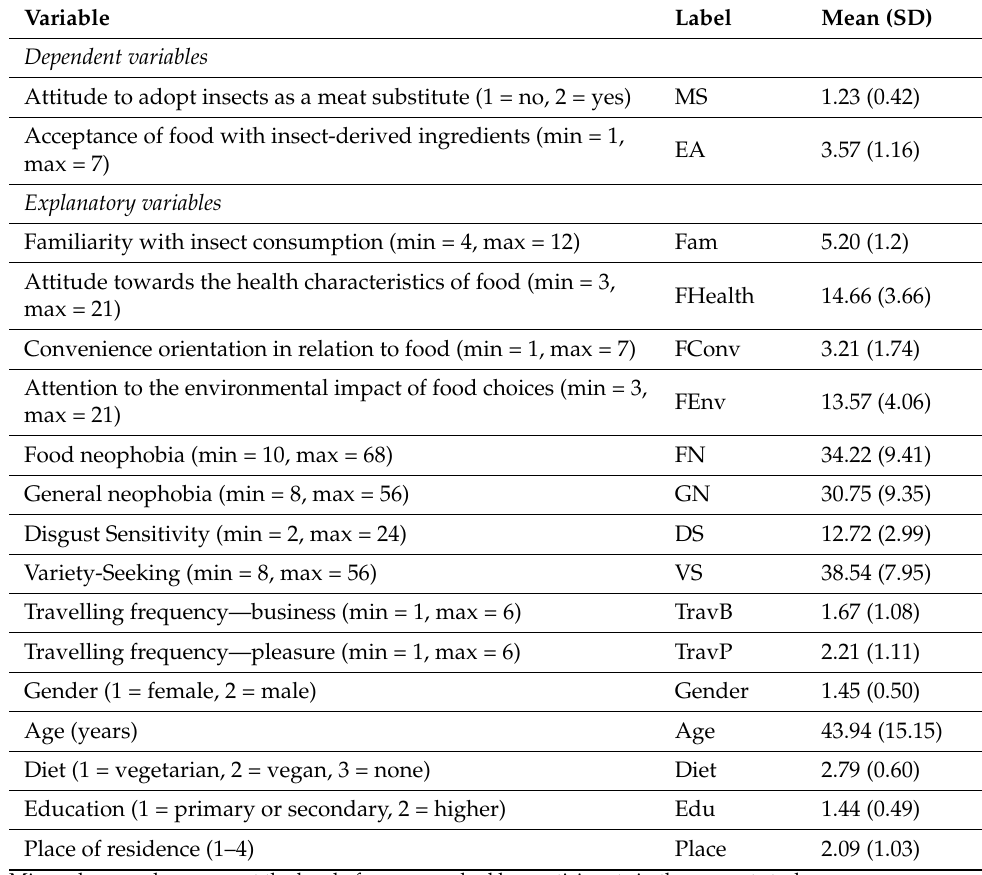
Table 1. Descriptive statistics of dependent and explanatory variables ( n =